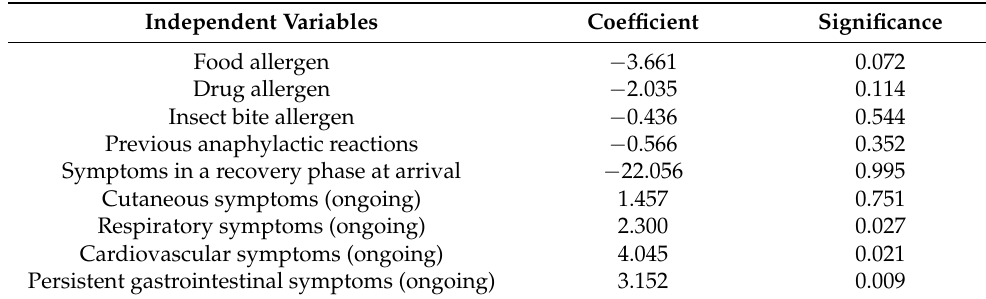
Table 5. Binary logistic regression with IM epinephrine administration as dependent variable and items list in columns 1 as independent variables. Coefficient points to direction of the